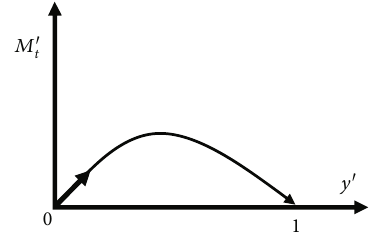
Figure 7: Customers select honest strategy.